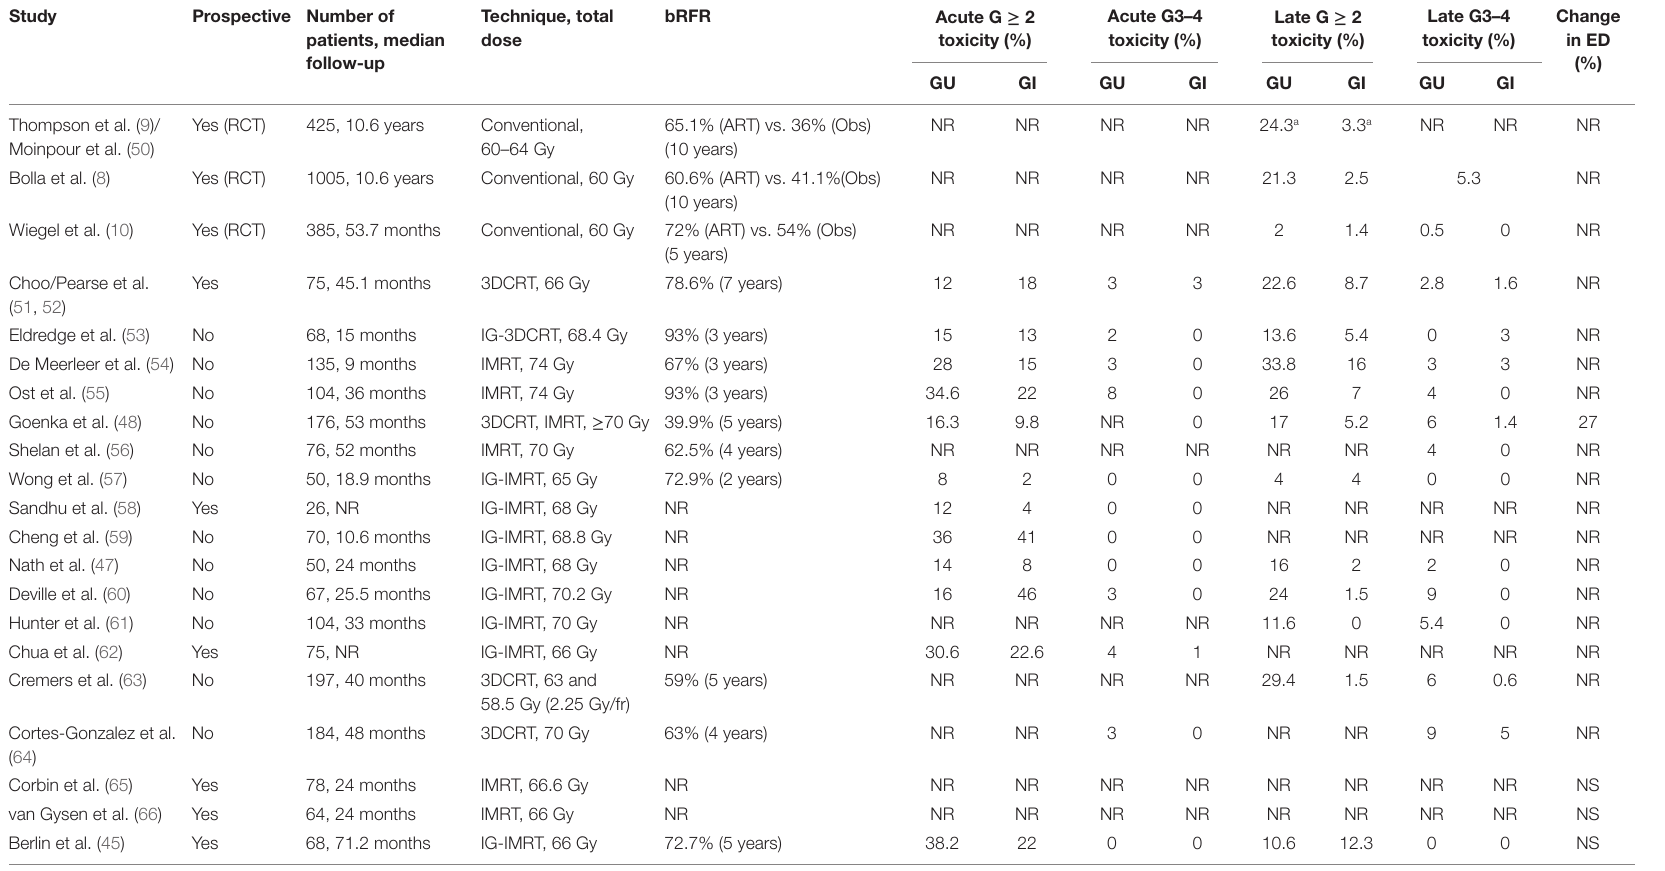
TABLe 1 | Summary of post-prostatectomy radiotherapy studies, outcomes, and